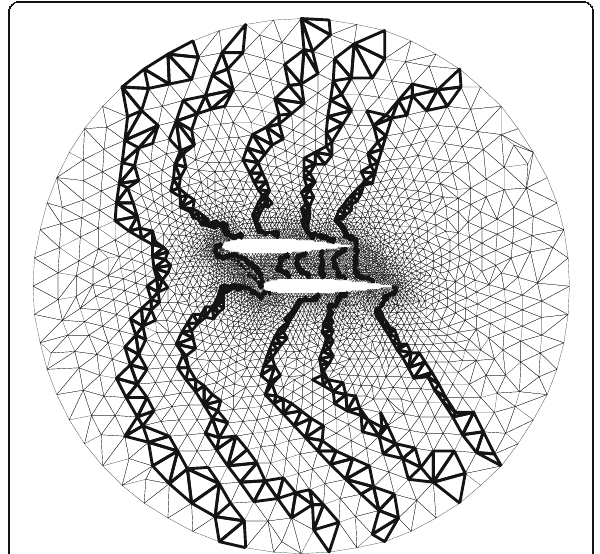
Fig. 10 Double airfoils: interface grids